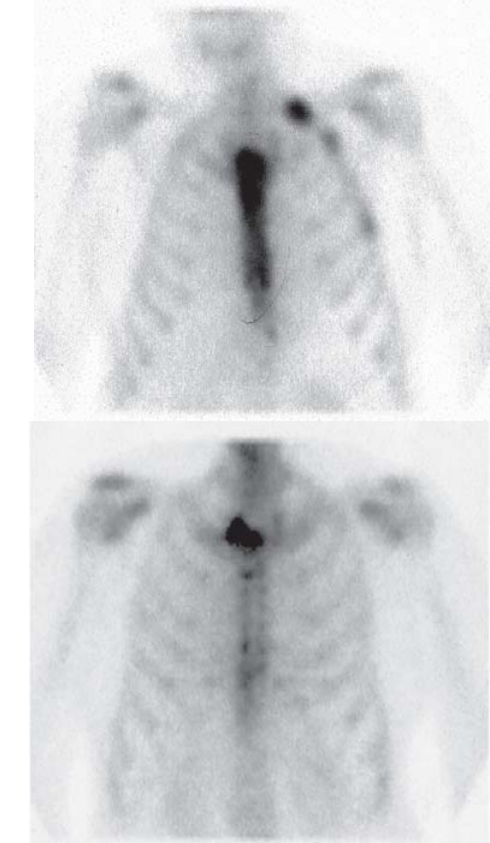
Fig. 1 - Exemplo de imagem cintilográfica avaliada no pós- operatório, observando-se em A paciente com hipercaptação e, em B, hipocaptação do radiomarcador